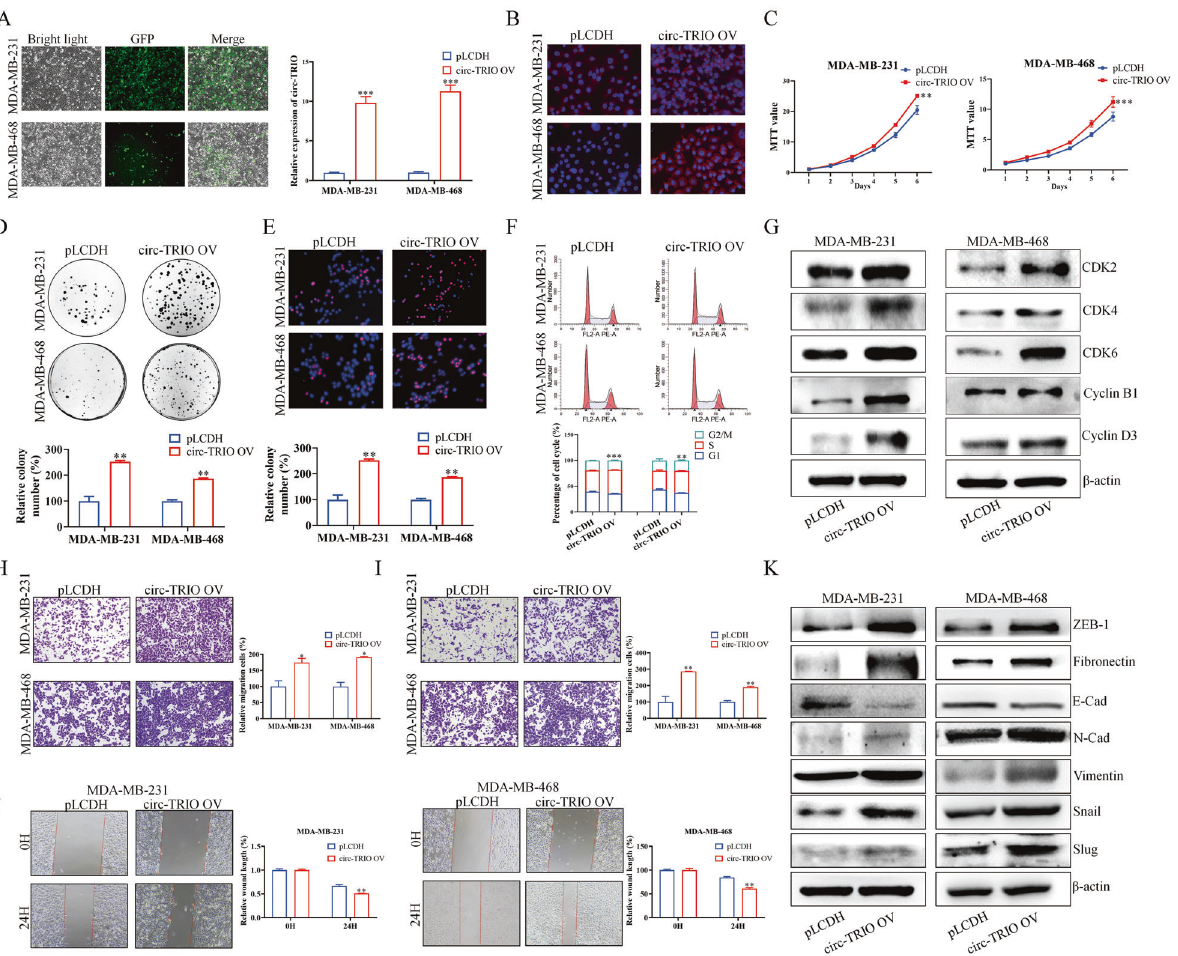
MTT ( C ) and fl at plate colony formation assays ( D ) were used to assess the proliferation rate of TNBC cells after the upregulation of circ-TRIO. EdU ( E ) and fl ow cytometry ( F ) assays were performed to evaluate the effects of circ-TRIO overexpression on the proliferative activities of TNBC cells. G Cell cycle-related proteins were examined after circ-TRIO overexpression. Transwell assays were performed to determine the in fl uence of circ-TRIO overexpression on migration ( H ) and invasion ( I ) abilities. J Wound-healing assays were also performed to identify the